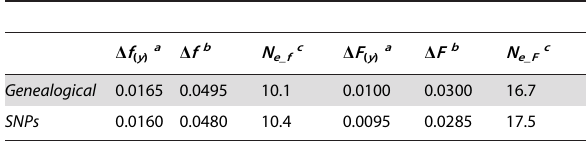
Table 2. Rates of coancestry and inbreeding per year and per generation and corresponding estimates of effective population size.